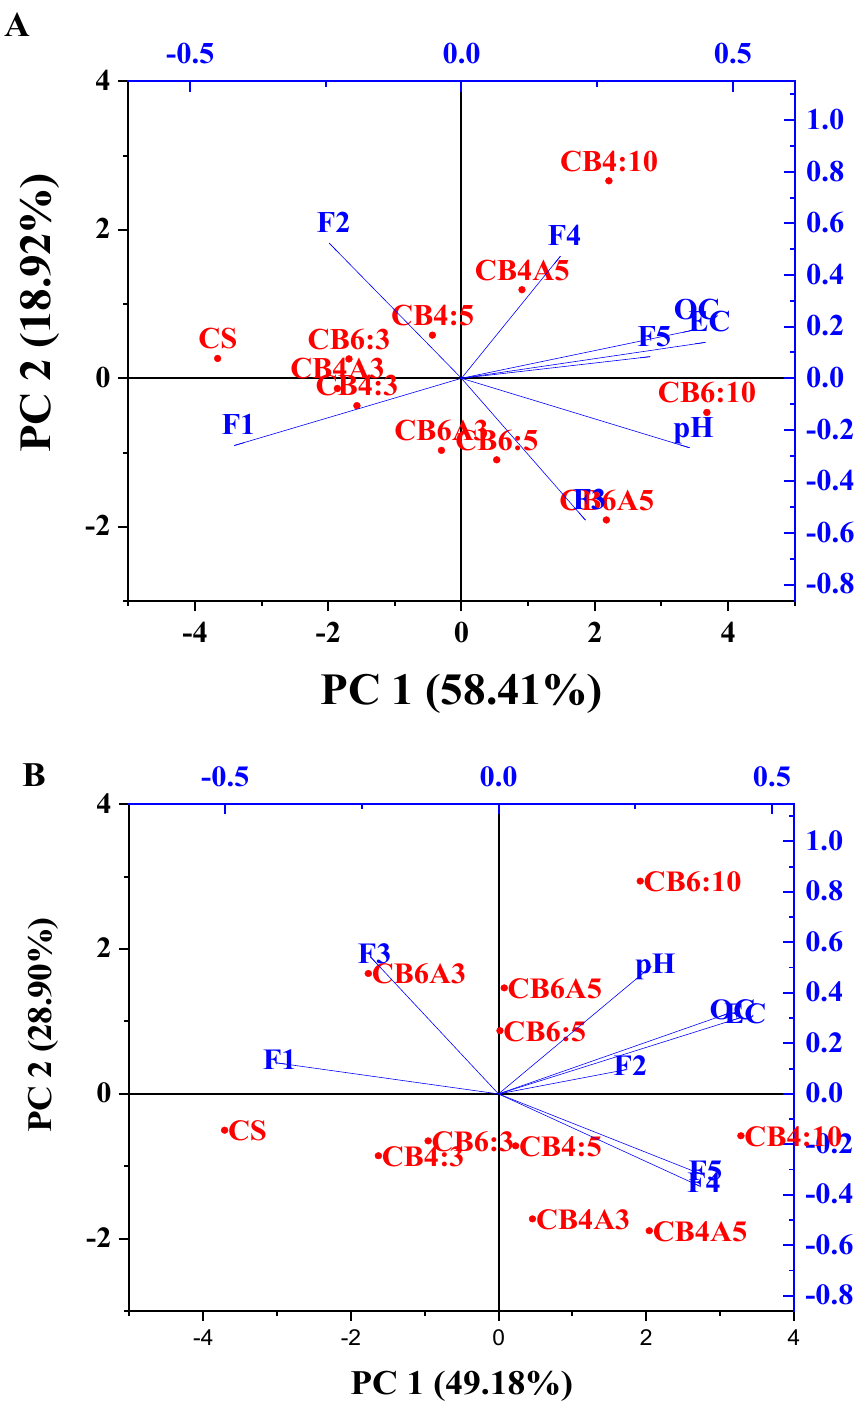
Figure 6. Two-dimensional principal component loading plot in the PCA results of the pH, EC, and OC with chemical fractions of Pb ( A ) and Zn ( B ). Figure 6A indicates that CB6:10, CB6A5, and CB6:5 were in the first group (group 1), and CB4:10 and CB4A5 were in the second group (group 2). These groups significantly changed the Pb chemical fractions compared to the control soil (CS). At the same time, the rest samples (CS, CB6:3, CB4A3, CB4:3, CB4:5, CB6A3) were in the same group (group 3), which had minimal or no effects on the chemical fraction of Pb after being incubated with biochar and apatite.